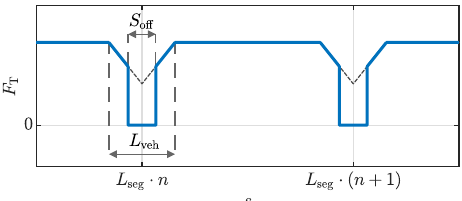
Figure 4. Generalized thrust profile for the single-inverter drive system.